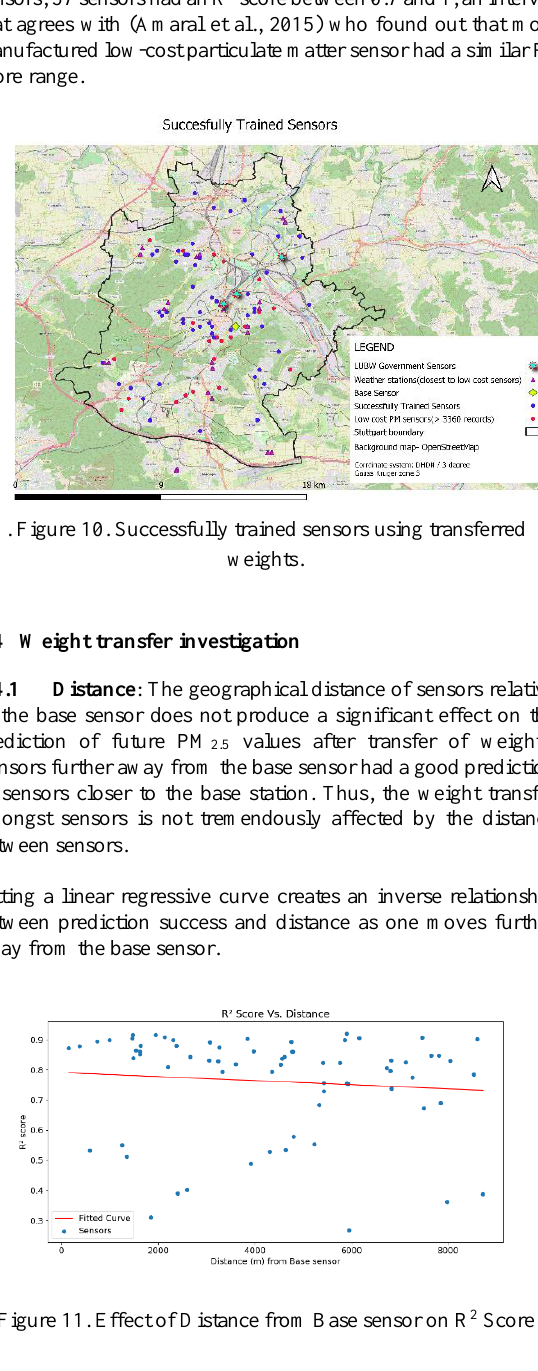
Figure 9. Prediction vs Actual PM 2.5 values using GRU SGD